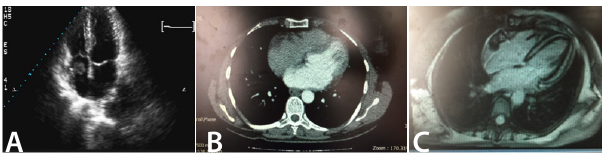
Fig. 3 – Preoperative cardiac images with different screening methods. A) transesophageal echocardiography, B) computed tomography, C) cardiac magnetic resonance imaging.